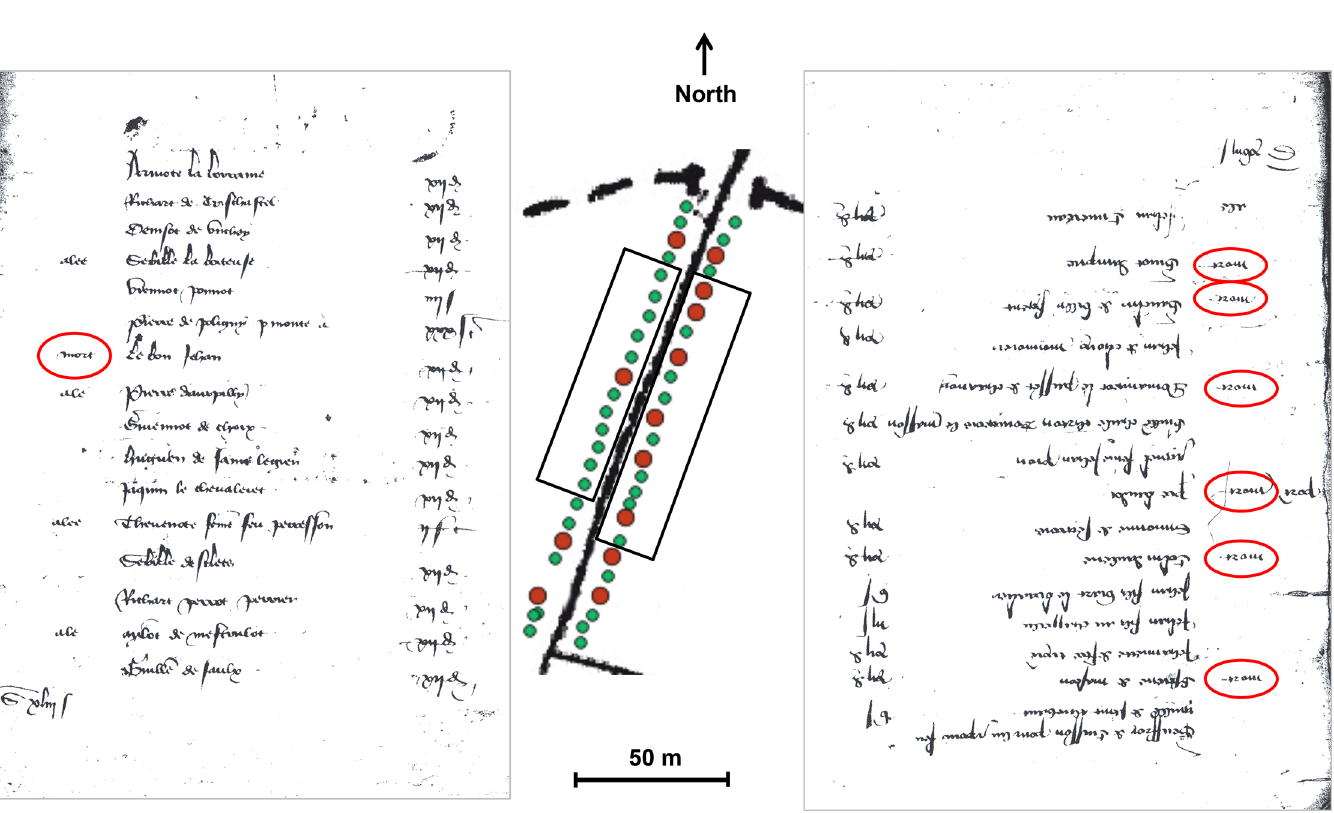
Fig 3. From marcs tax register to cartography of death. A copy of two folios corresponding to either side of Fermerot Street in 1400 shows the contrasting mortality between the western and the eastern sides of the street. On the left is folio 1v that enlists households standing on the western side of the street. On the right is folio 2v that enlists households standing on the eastern side of the street. Folio 2v is upside down to fit with the direction of recording (see below). As indicated in the left margin (on the right side for folio 2v), each head of household can be a deceased ( mort , "dead"), an absent ( ale or alee , "gone") or a survivor (no indication). The red circles indicate the deaths. Deaths are more numerous in folio 2v and all of them correspond to grouped deaths, as they are closely associated with other deaths in the register file (in folio 2v or in the previous or following folio). The map in the centre of the figure is the enlarged corresponding section of the georeferenced map. Each point corresponds to a surviving head of household (green points) or to a registered death (larger red points), and the points outside Fermerot Street have been erased. The "gone" (4 in folio 1v and 1 in folio 2v) do not appear in the map, as they were not taken into account in this work. The putative path of the tax collector starts from Fermerot gate (below the North indication), goes towards south along the western side of the street, lined by the Clairvaux abbey enclosure , turns at the end of the street, and returns along the eastern side of Fermerot Street towards the north. The rectangles indicate the households included in the corresponding folio of the marcs tax register. Folio 2v and the corresponding eastern side are inside the cluster of higher grouped death relative risk, whereas folio 1v and the western side are outside (Fig 2). The western side of Fermerot Street at